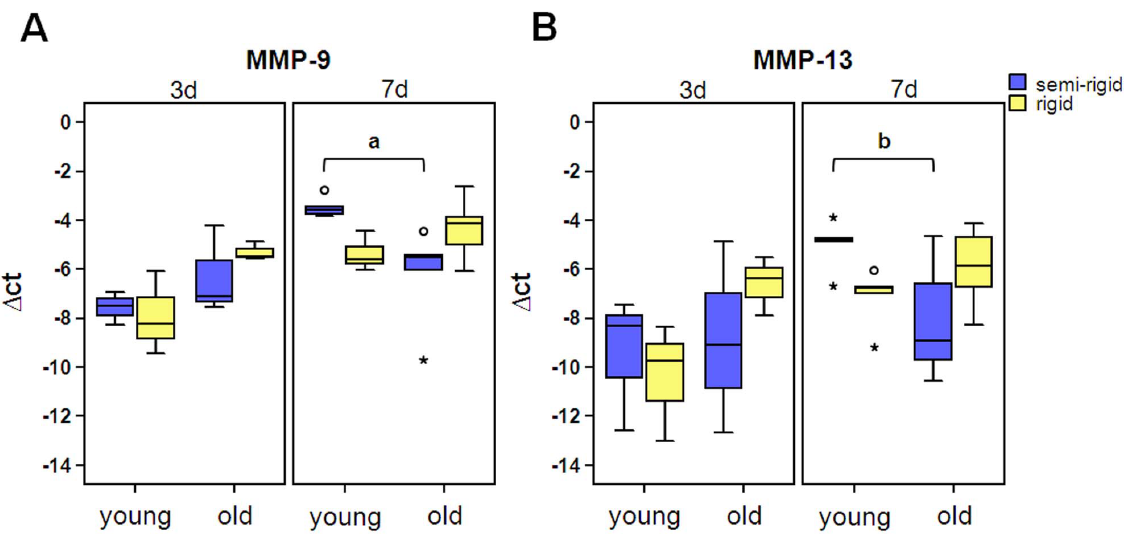
Figure 4. Gene expression of MMP-9 and -13 were significantly affected by the interaction of fixation and age. The expression of mRNA of YR, YSR, OR and OSR was evaluated by quantitative qRT-PCR, normalized for the housekeeping genes (HKG) Actb , Gapdh , and Eef1a and quantified using the delta-Ct-method: D ct = ct (geo mean HKG) - ct (gene of interest). (day 3, n=3 RNA pools a´ 3 animals; day 7, n=5; a, p =0.019; b, p =0.057; u , outlier; *, extreme value)